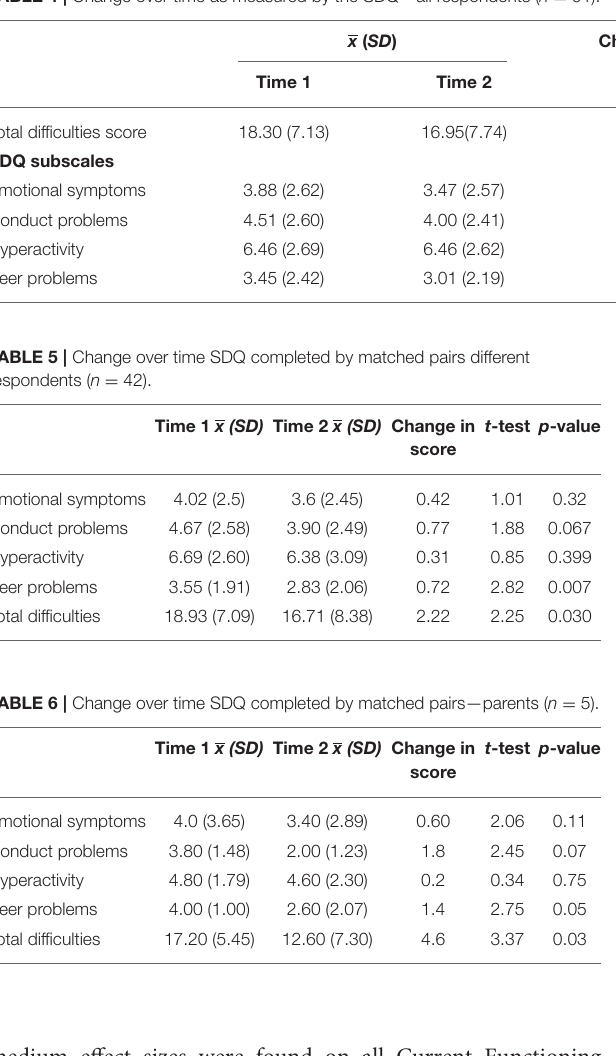
TABLE 4 | Change over time as measured by the SDQ—all respondents ( n = 91).